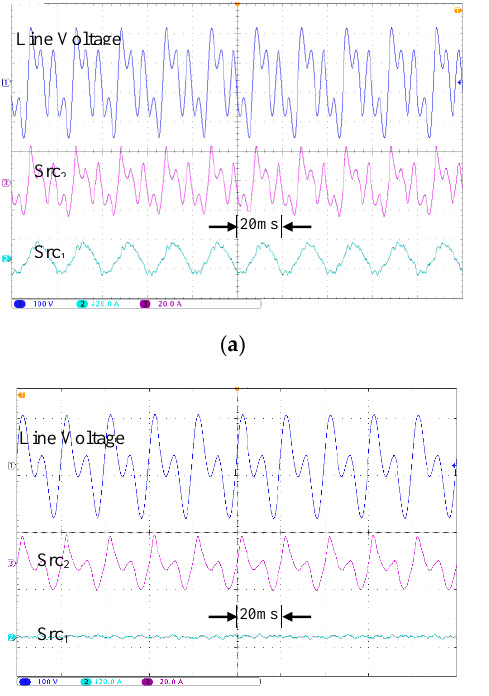
disconnection where one source supplies power to the grid channel only while the other feeds power to all channels;